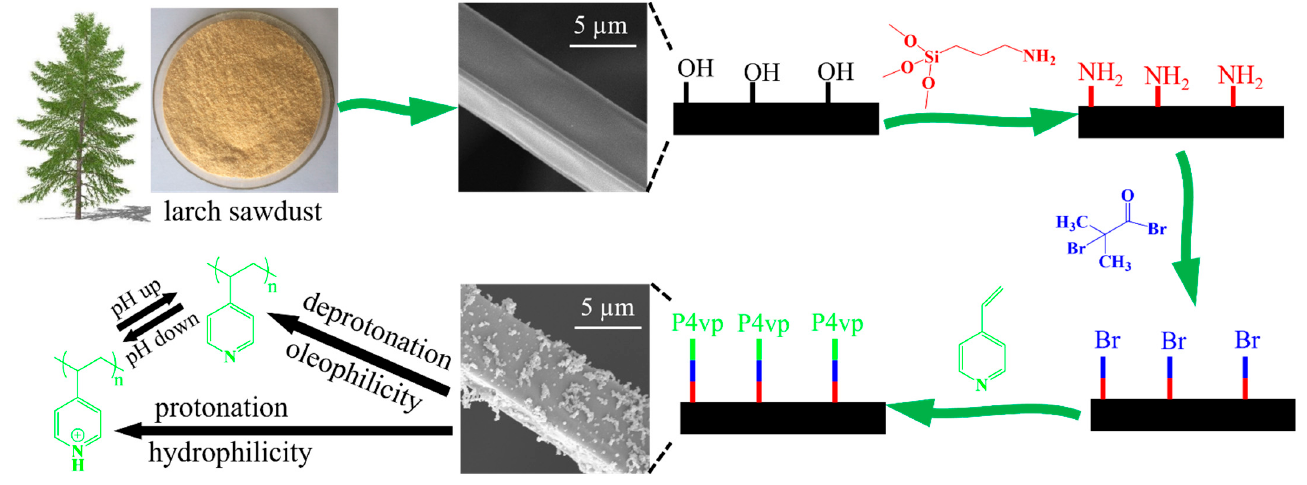
Figure 1. Schematic illustration of the synthesis of CF-P4vp.